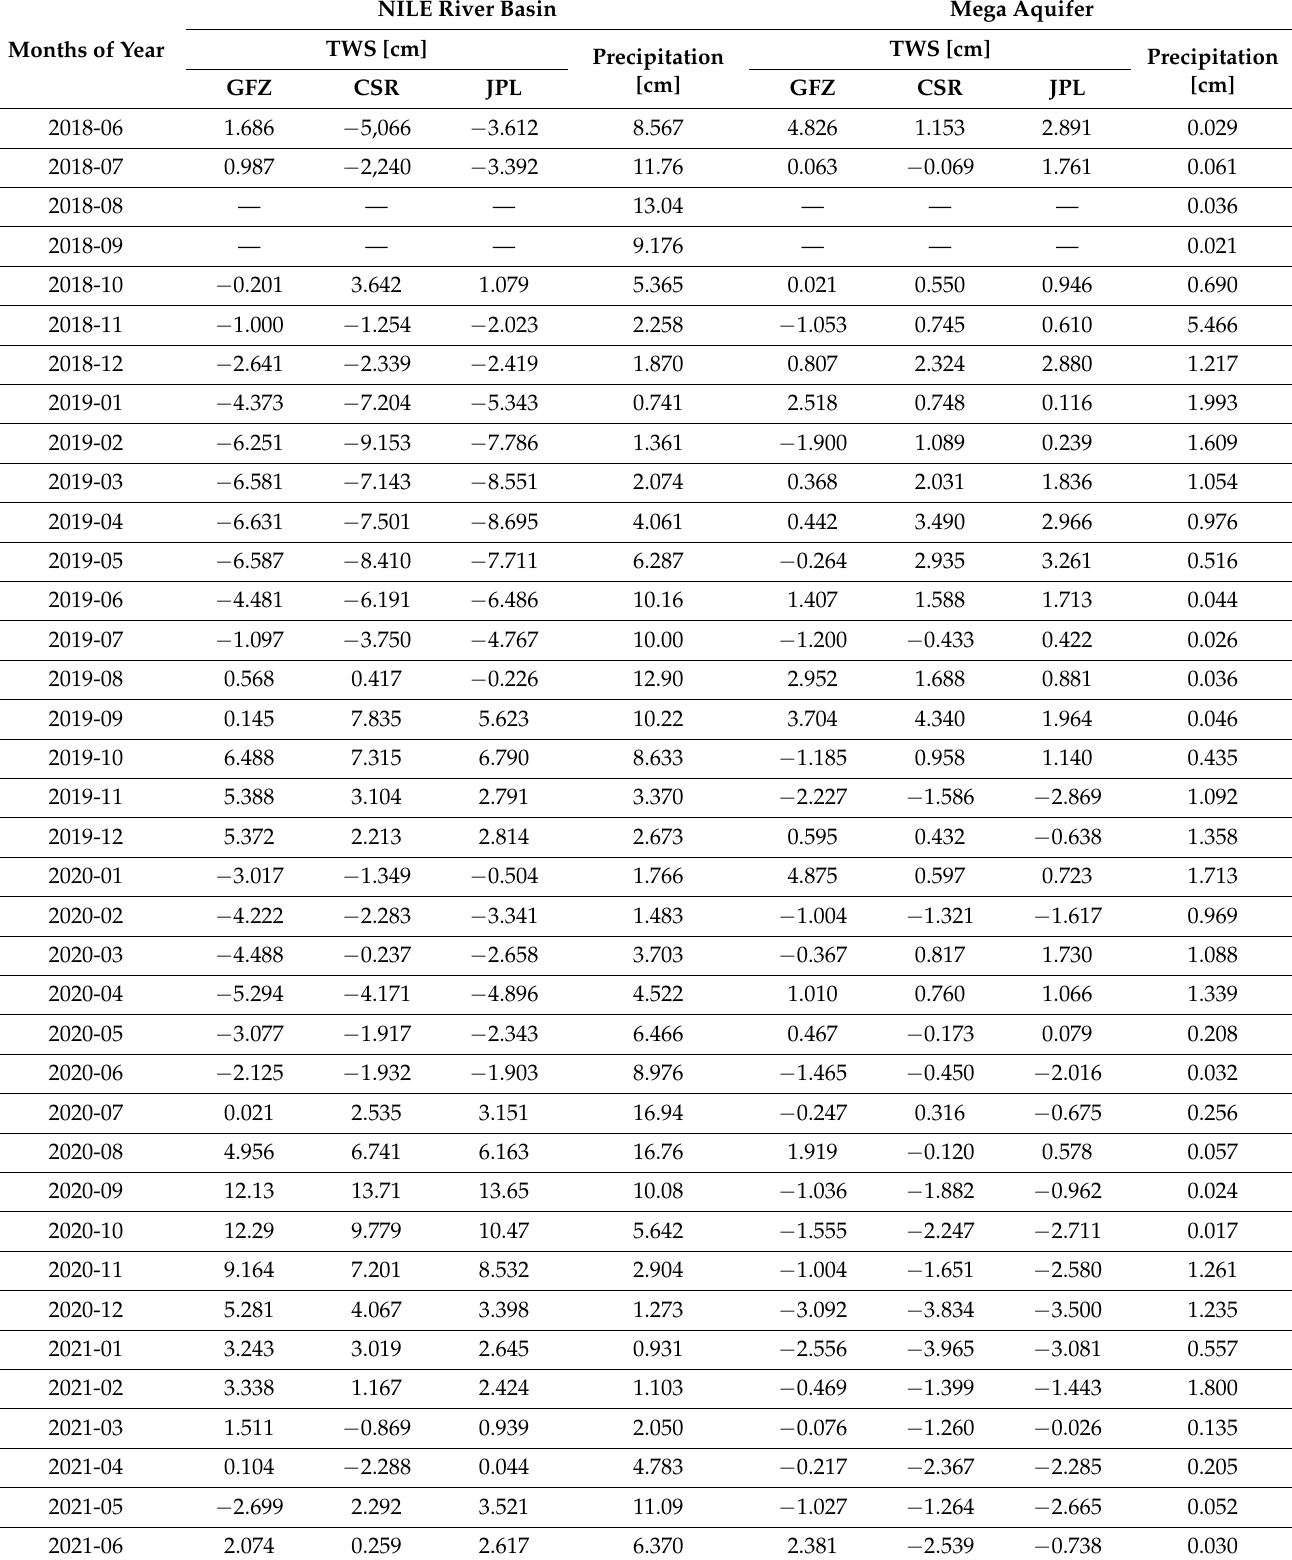
Table 1. Mean Basin average of the TWS signal [in cm] and average monthly precipitation [cm] over the NRB and MAS. The TWS statistics are derived from the DDK5 of GRACE-FO (RL06) gravity field products from GFZ, CSR, and JPL official centers, while the precipitation ones are derived from the GPCP